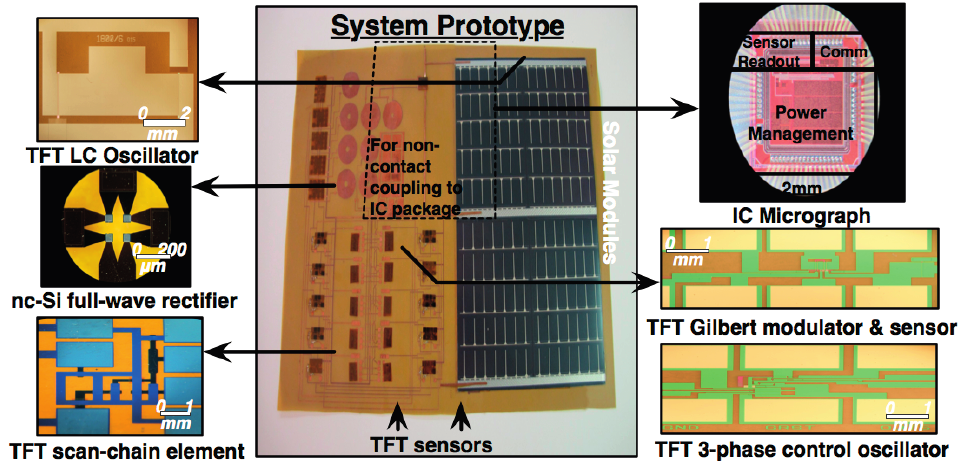
Figure 3. Prototype of sensing sheet for the SHM application (courtesy of Naveen Verma and Yinzhe Hu